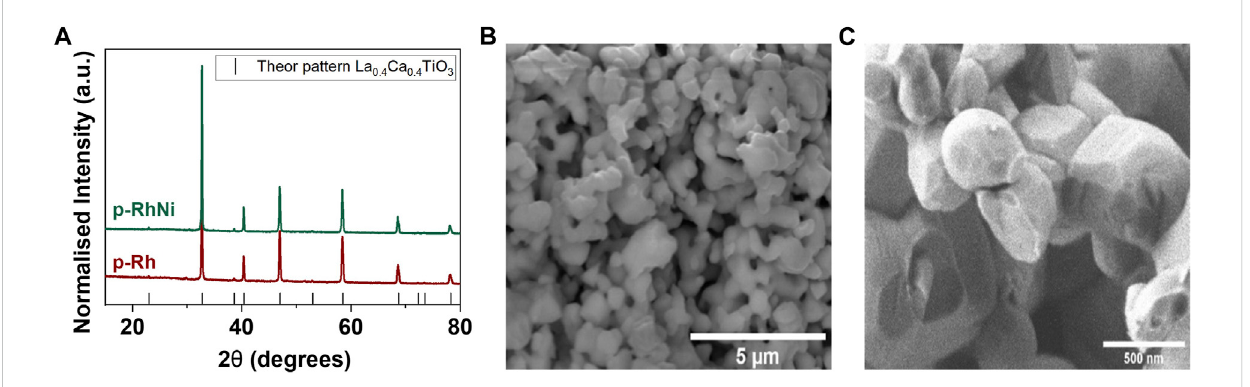
FIGURE 1 Preparing Rh-Ni doped perovskites (A) X-ray diffraction spectra of the as-prepared samples La 0.43 Ca 0.37 Rh 0.03 Ti 0.97 O 3 (Rh 3 ), and La